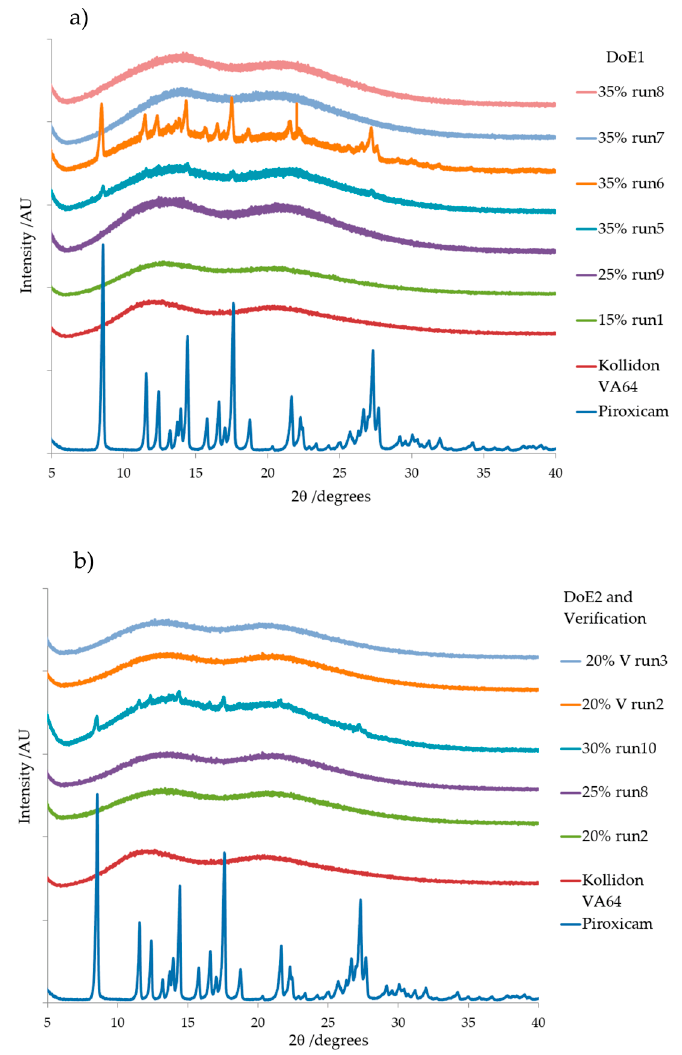
Figure 12. XRD diffraction patterns of ( a ) DoE1 runs and ( b ) DoE2 and verification runs. Pure PRX and pure Kollidon ® VA64 are shown as reference. Note: V = verification.